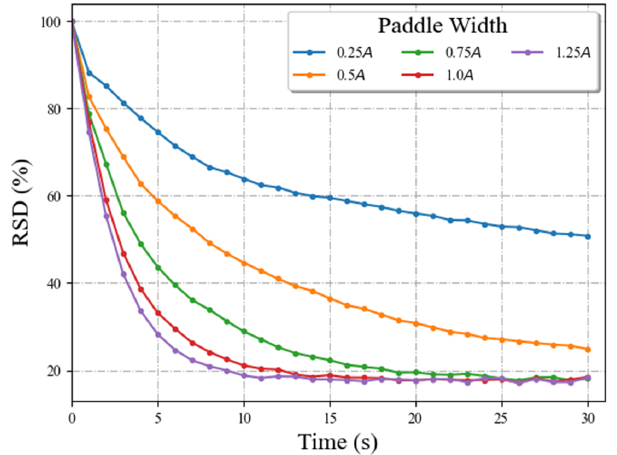
Figure 9. RSD values versus time for various paddle widths for 40 RPM, 40 % fill level and 0° paddle angle.